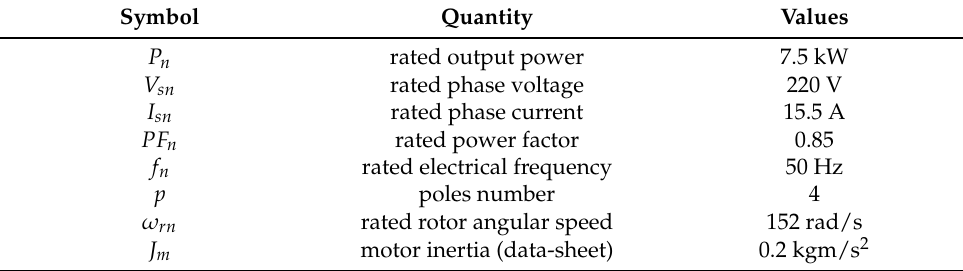
Table 1. Data from the motor nameplate and